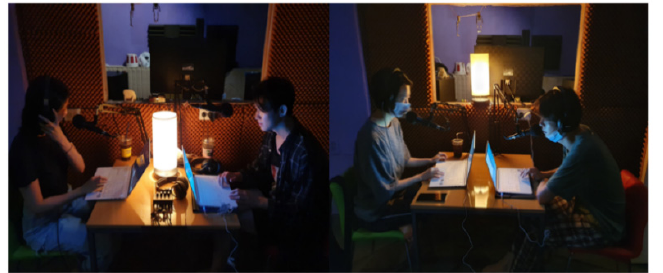
Figure 1. Two actors during recording, using a conversation between a male and a female. After recording, the data were manually segmented by dialog turn (speaker turn) from continuous segments in which the actors were actively speaking. The scripts were segmented into sentences in advance, and used as references with which to split the data. The final audio recordings were divided into approximately 3–10 s long files. Each file